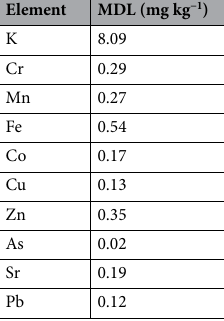
Table 3. MDL values (mg kg −1 ) of most analyzed